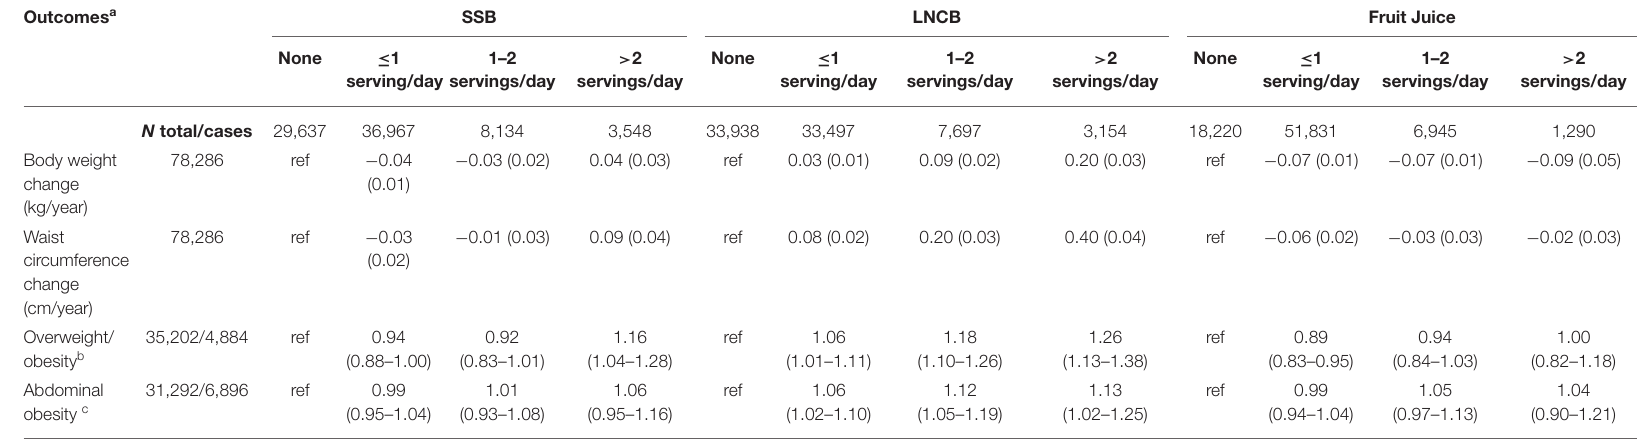
TABLE 3 | Adjusted associations between sugar-sweetened beverages, low/no-calorie beverages, fruit juice consumption, and weight-related outcomes categorized by intake levels. Outcomes a SSB LNCB Fruit